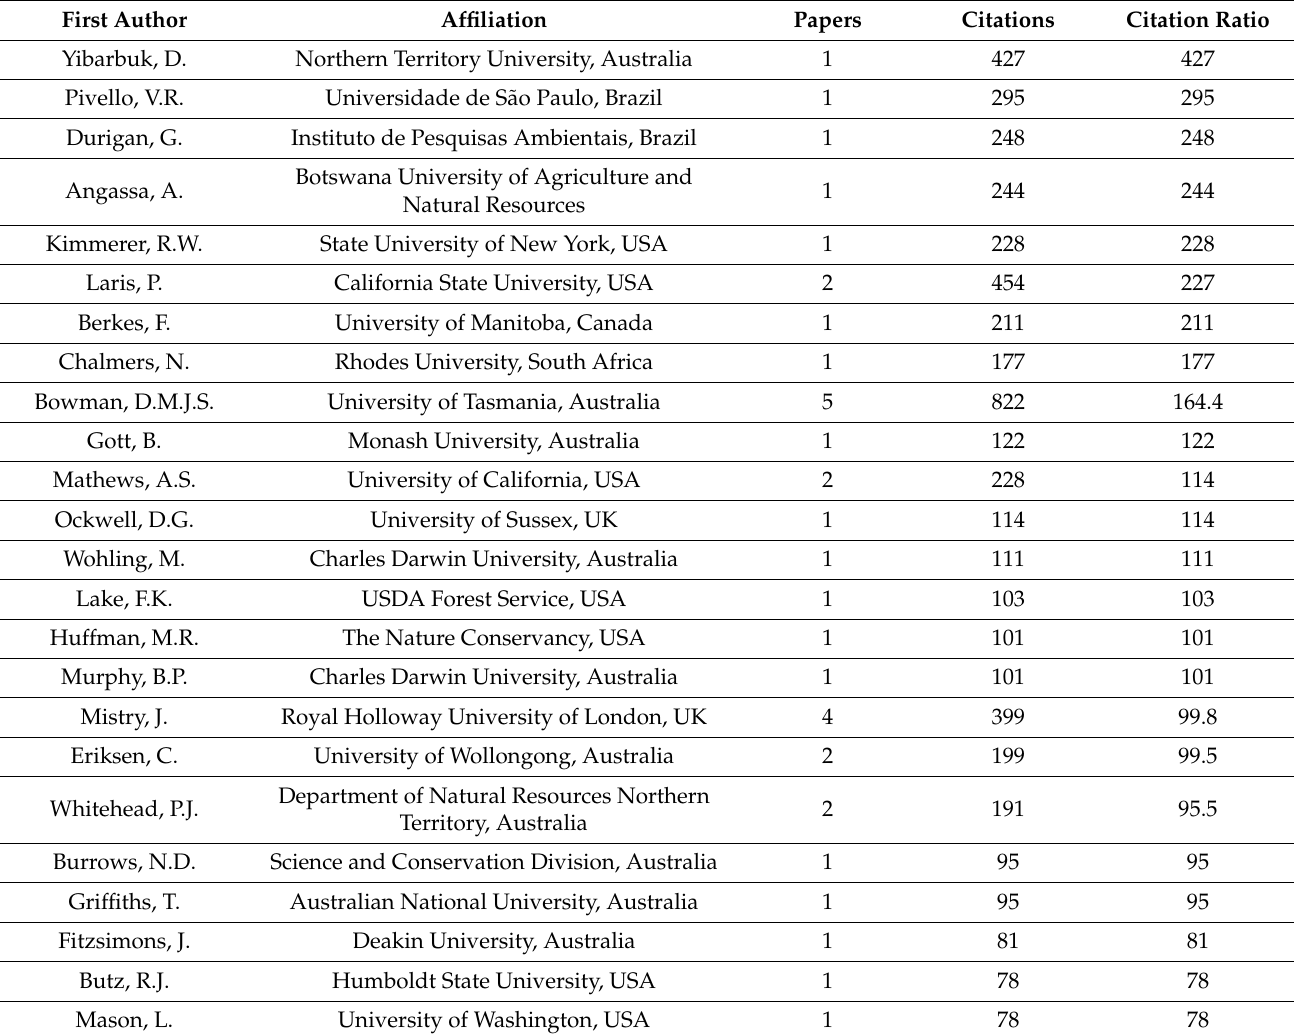
Table 3. Leading researchers in the field by most cited